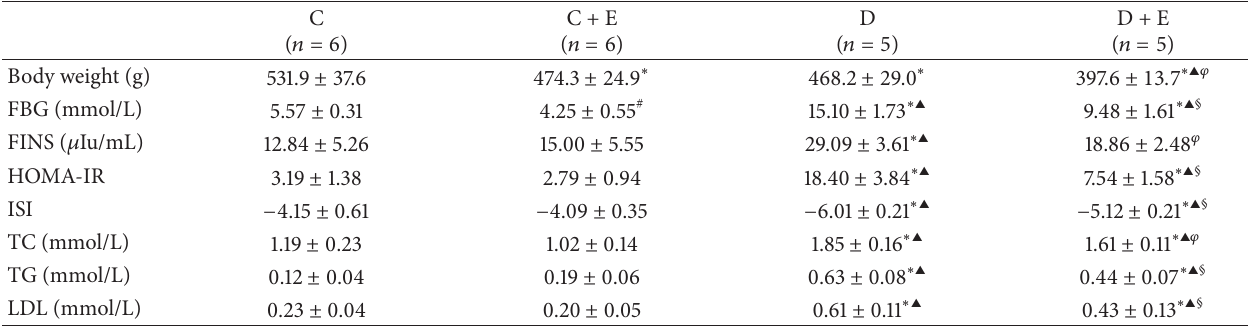
Table 1: Characteristics of rats in the four groups at the end of